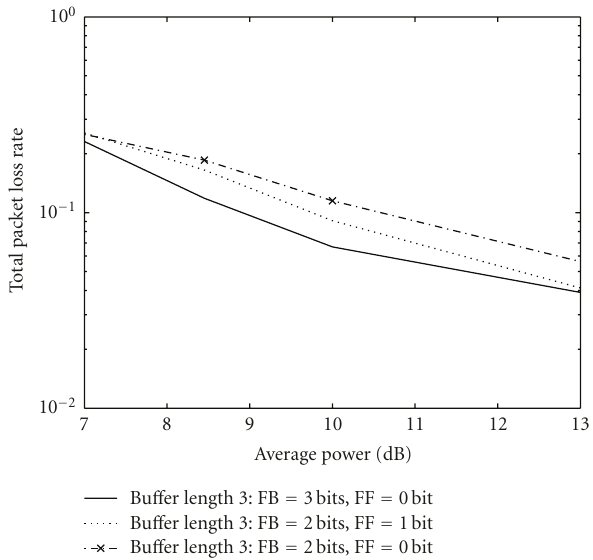
Bu ff er length 3: FB = 2bits, FF = 0bit Figure 8: Variation of average packet loss with SNR for statistical TBIR and instantaneous TBIR with bu ff er length L =